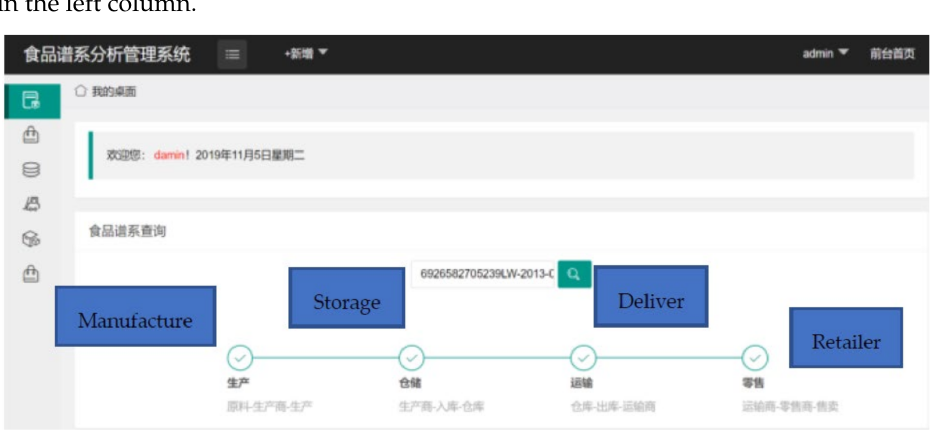
Figure 13. Food Supply Chain in Client